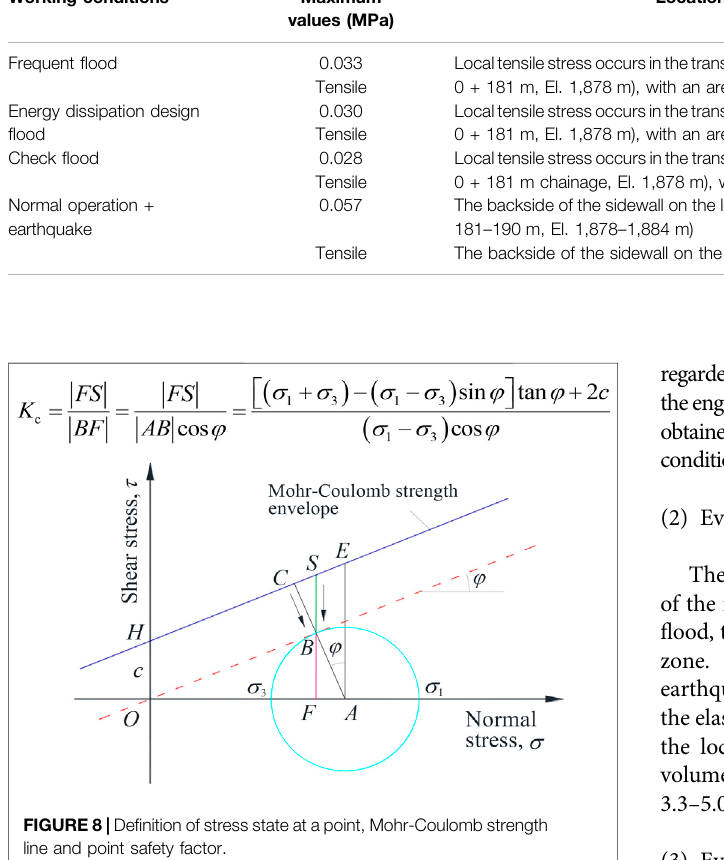
Frontiers in Physics |